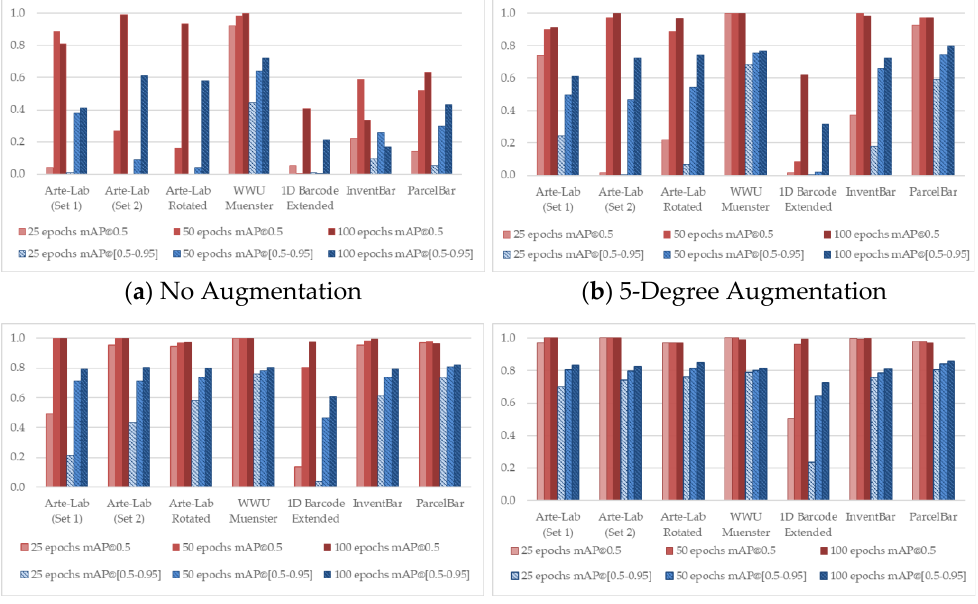
Figure 7. Recognition rate of YOLO v5 applied over seven public barcode datasets.